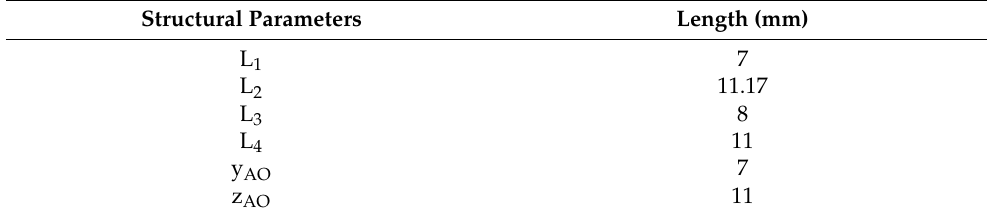
Figure 2. Schematic of the flapping mechanism. Table 1. Parameters of the flapping mechanism.